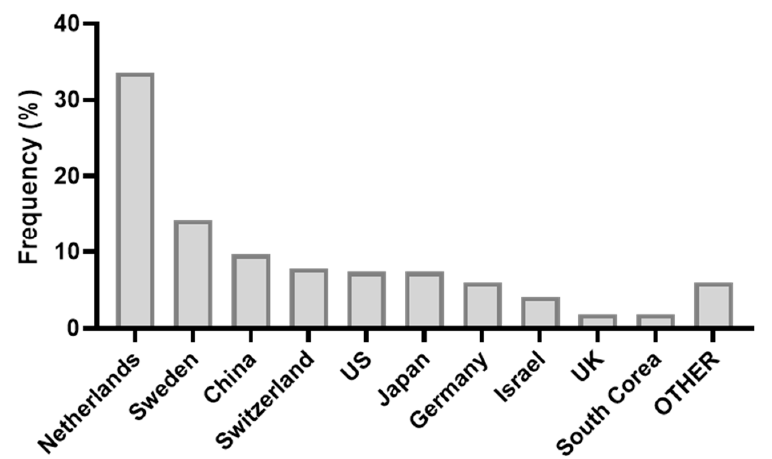
Figure 8. Patents: geographical distribution of applicants’ affiliations.